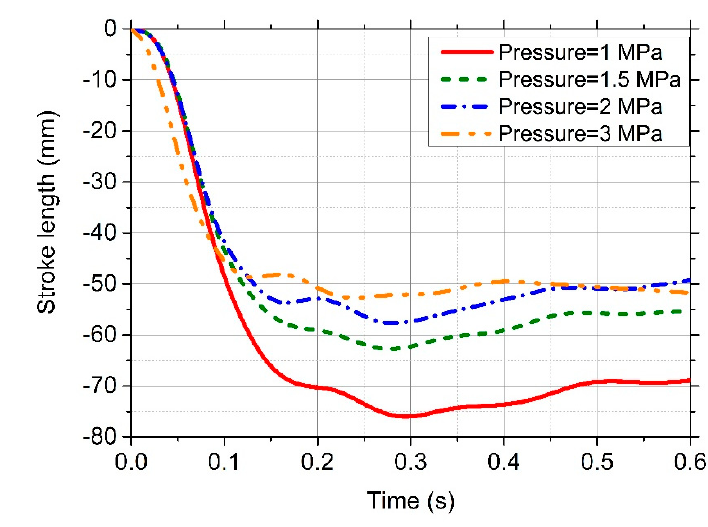
Figure 18. Changes of stroke length of arresting hook at different inflation pressure.